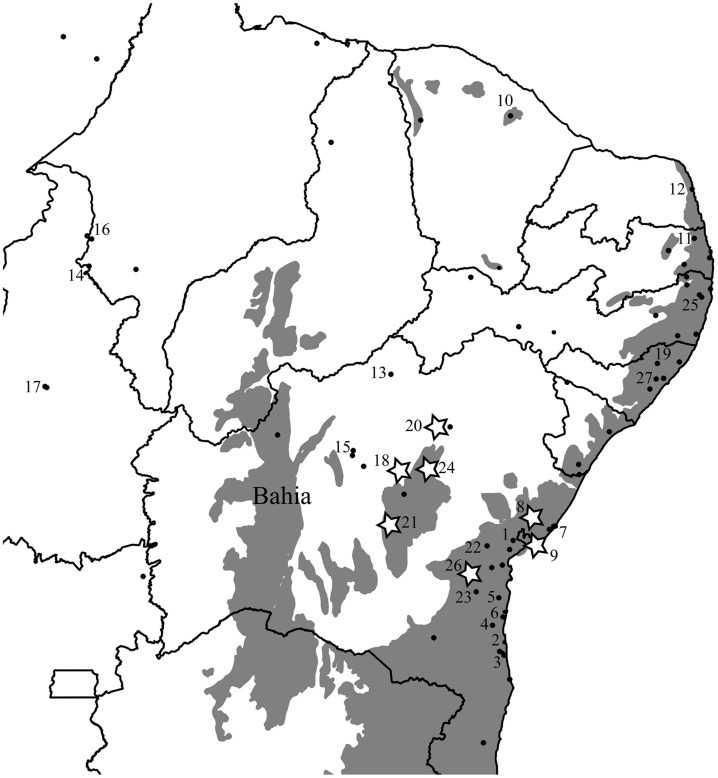
Original extent of the Brazilian Atlantic Forest biome (in gray; SOS Mata Atlântica and Instituto Nacional de Pesquisas Espaciais, 2012) and the distribution of coastal (core) and isolated (inland) populations of Coleodactylus meridionalis. Numbers correspond to localities included in the genetic analyses and those with stars were included in the physiology dataset. State lines are represented and the State of Bahia is labeled. Only Coleodactylus natalensis (morphologically and ecologically distinct clade embedded within Coleodactylus meridionalis) is found in locality 12.